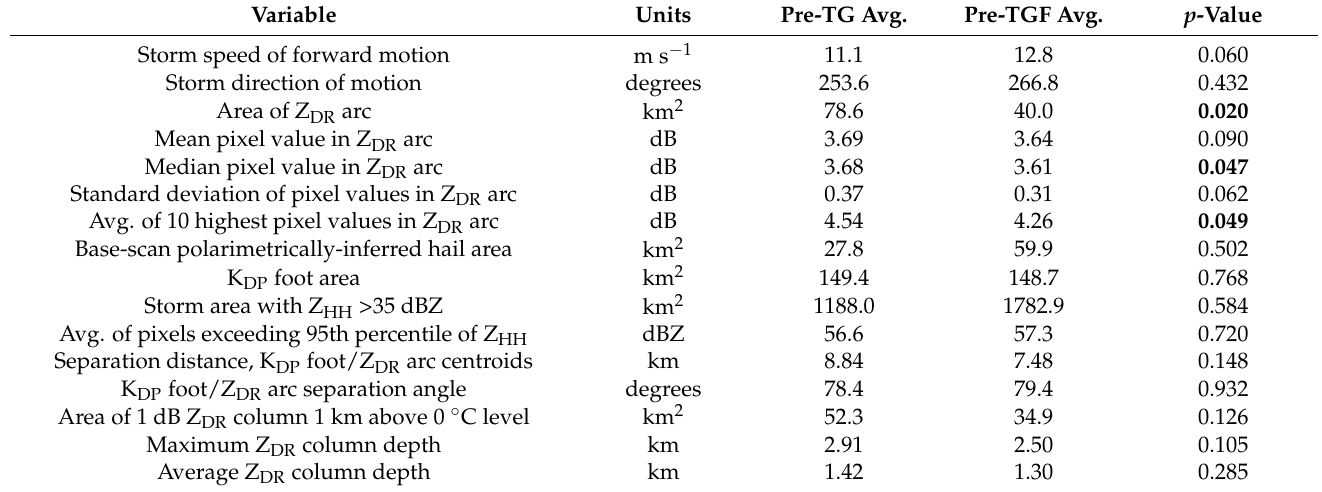
Table 4. Average value of each radar metric examined for pre-tornadogenesis (Pre-TG) and pre-TGF storms, and WMW p -value comparing these two populations. p -values < 0.05 (95% confidence that the storm subsets are distinct) are highlighted in bold.